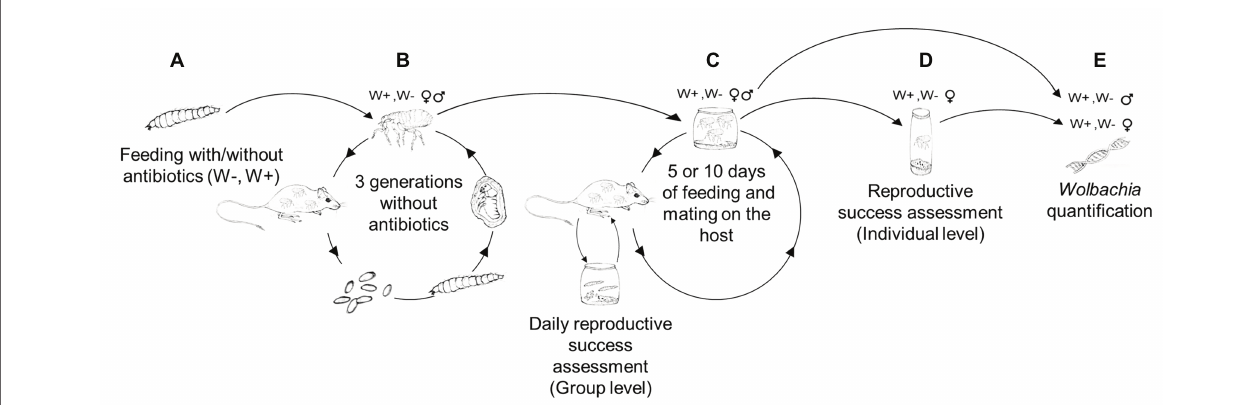
FIGURE 1 | Experimental design. (A) Larval Synosternus cleopatrae fleas were randomly assigned to two treatment groups: a group that received antibiotics as a supplement to their food, Wolbachia -free (W − ) and a control (W + ) group. (B) Fleas from the two groups were reared on rodents for three additional generations without the antibiotic supplement. (C) Each treatment group was randomly divided into six subgroups, each subjected to either 5 or 10 days of feeding and mating. Specifically, the fleas were allowed to feed daily for 2 h on rodents and then collected and incubated overnight in separate boxes, where the average daily reproductive success of the group was assessed. (D) At the end of the three experimental stages, all female fleas were individually subjected to reproductive success assessments. (E) Then, a subset of fleas was subjected to Wolbachia